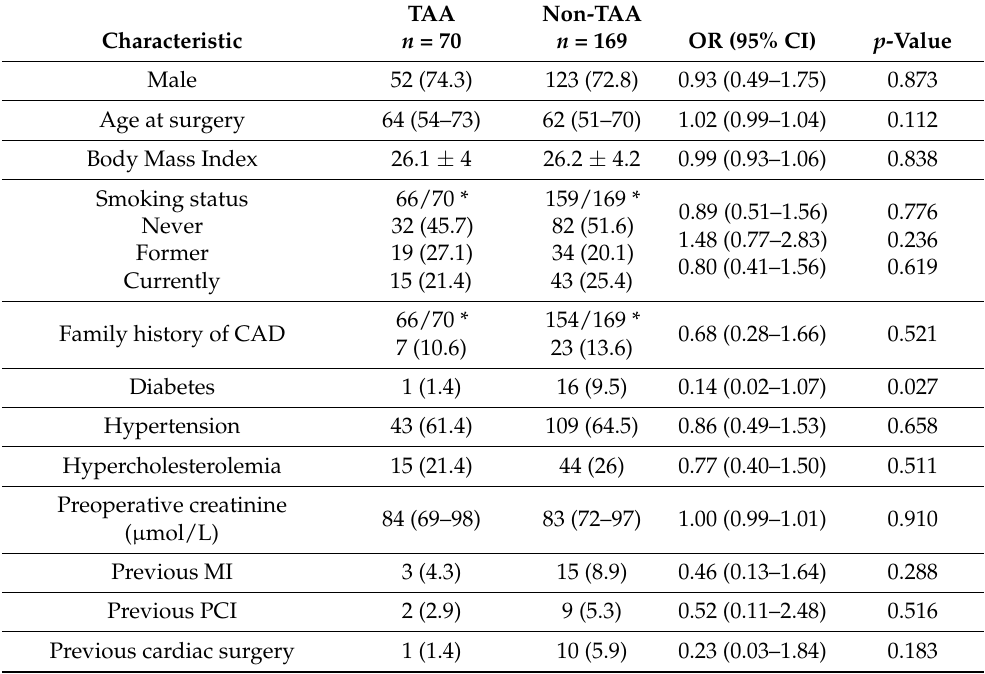
Table 1. Baseline